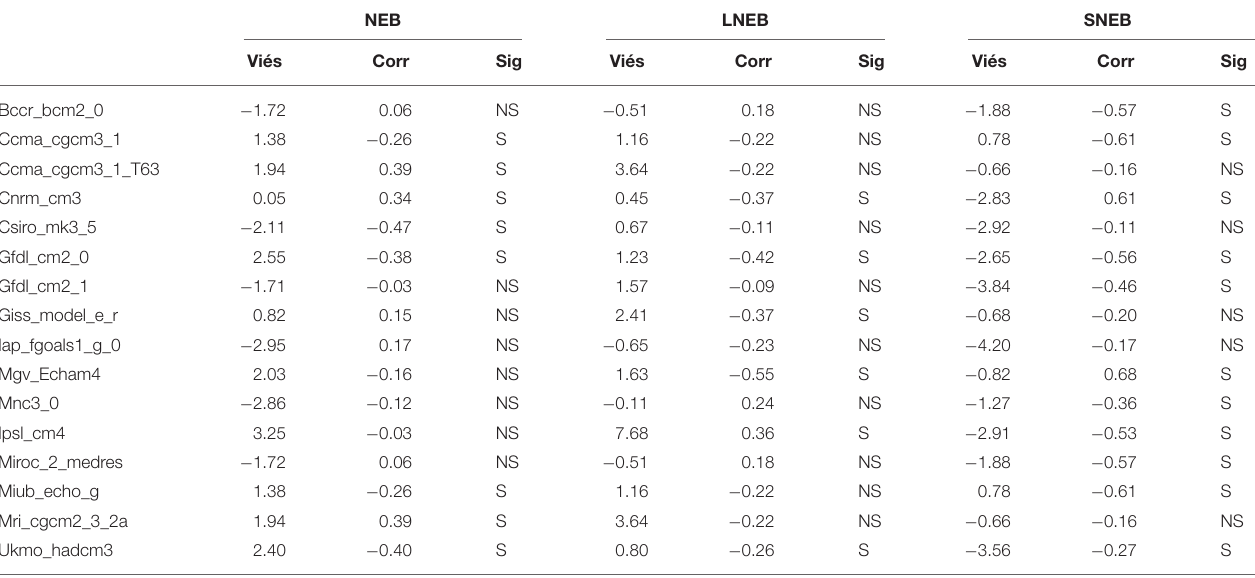
TABLE 3 | Correlation and bias between the autumn rainfall simulated by the CMIP5 models and observations in CMAP. NEB LNEB SNEB